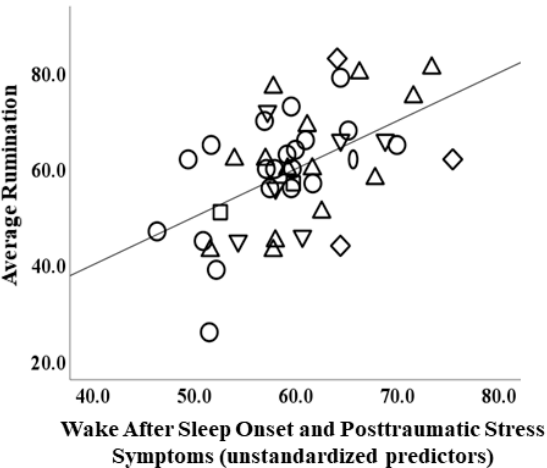
Figure 1. Scatterplot depicting relationship between actigraphic wake after sleep onset and post- traumatic stress symptoms (PTSD Checklist-Civilian Version) (unstandardized predictors) and ru- mination (ruminative response scale). Note: circle = principal generalized anxiety disorder; upright trian- gle = principal major depressive disorder; oval = principal panic disorder; square = principal persistent depres- sive disorder; diamond = principal posttraumatic stress disorder; downward triangle = principal social anxiety disorder.